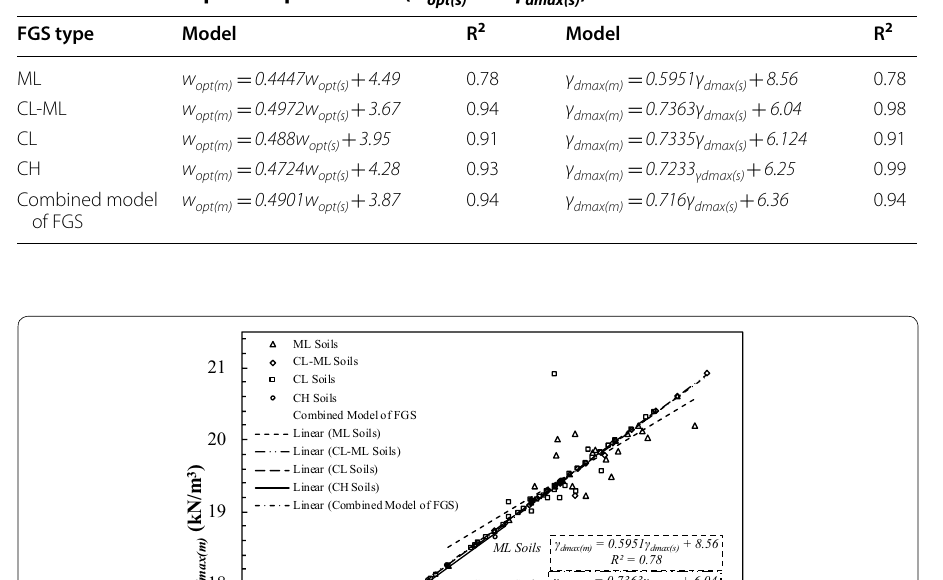
Table 2 Correlations of modified compaction parameters ( w with standard compaction parameters ( w